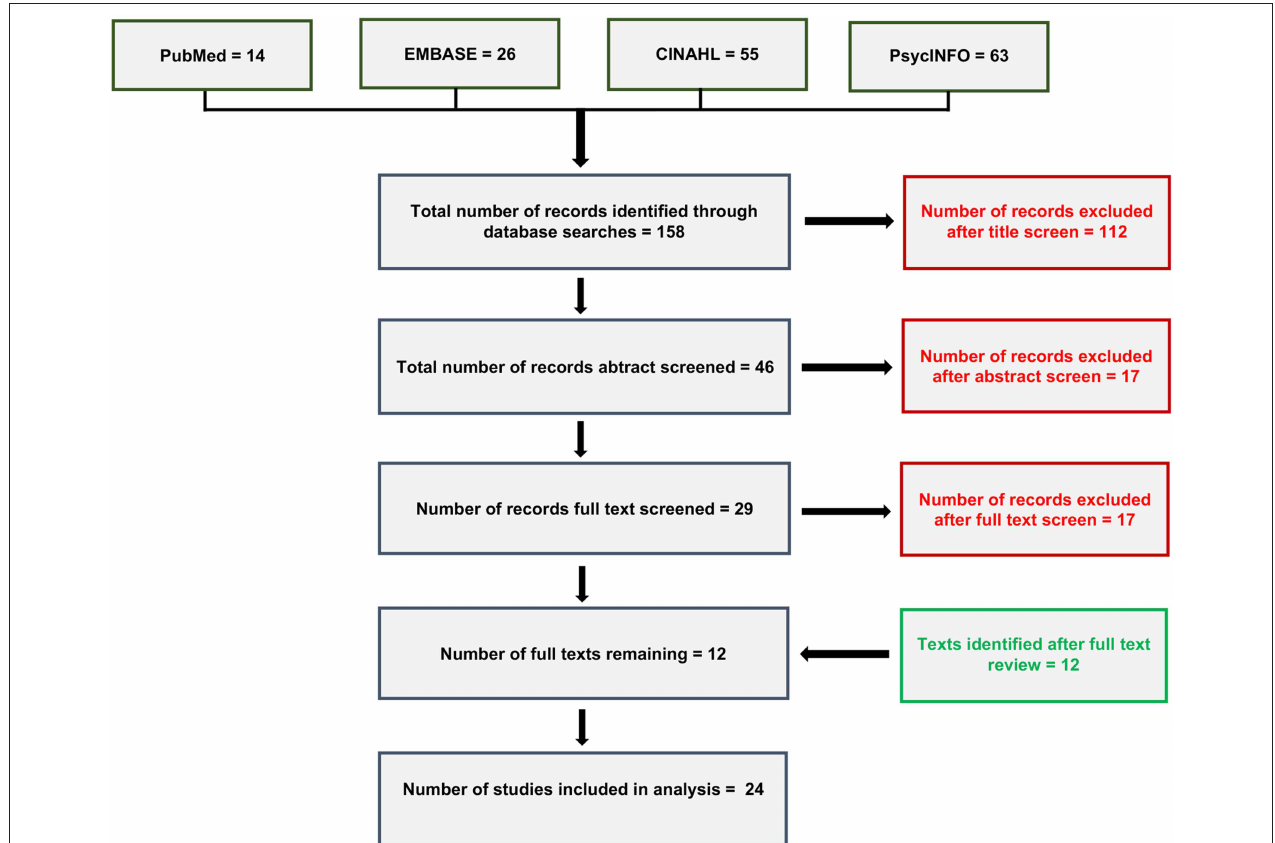
FIGURE 1 | Literature review diagram showing article review and